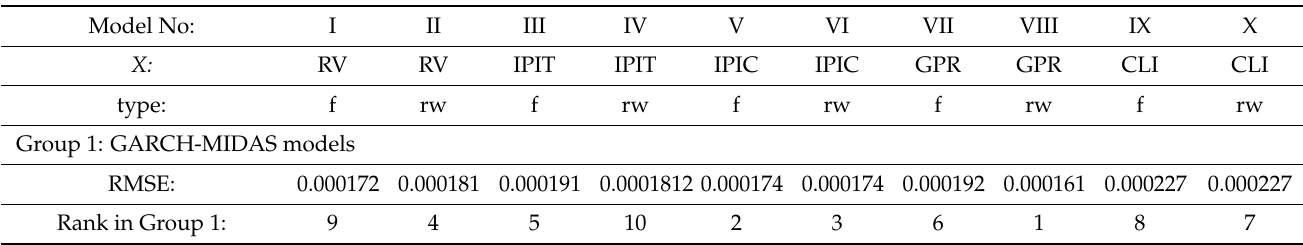
Table 6. Out-of-Sample Forecast Results, 23 Days